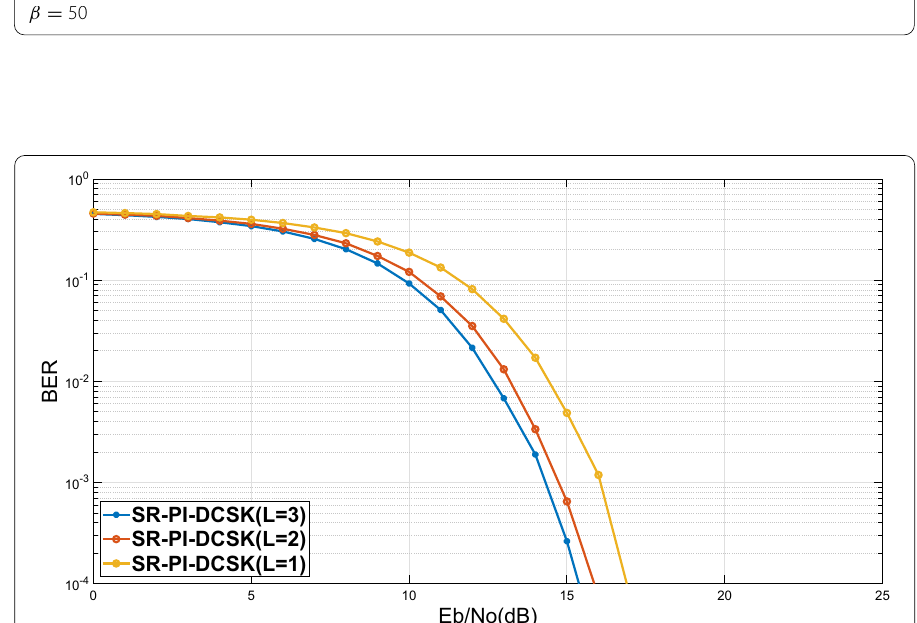
Fig. 9 The bit error rate performance at different frame lengths ( L = 1 , L = 2 and L = 3 ) for SR‑PI‑DCSK for β =